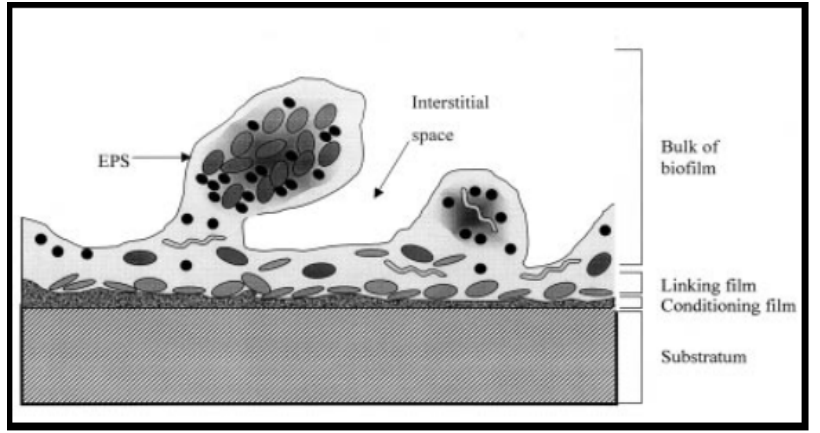
Figure 9. Mature biofilm layers, including the bulk of the biofilm, linking film, conditioning film, and the substratum to which the film is attached [37]. Reprinted with permission from ref. [37].© 1999 John Wiley and